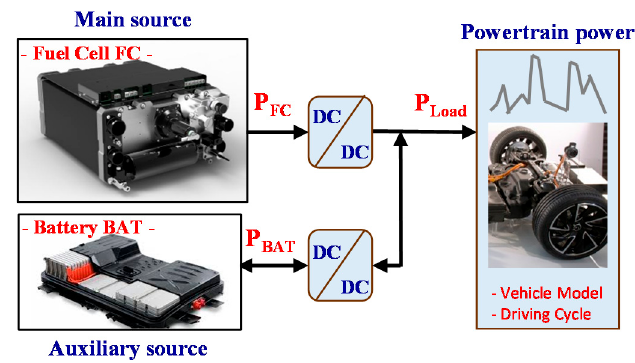
Figure 1. Parallel hybrid FC/BAT power source architecture [28].